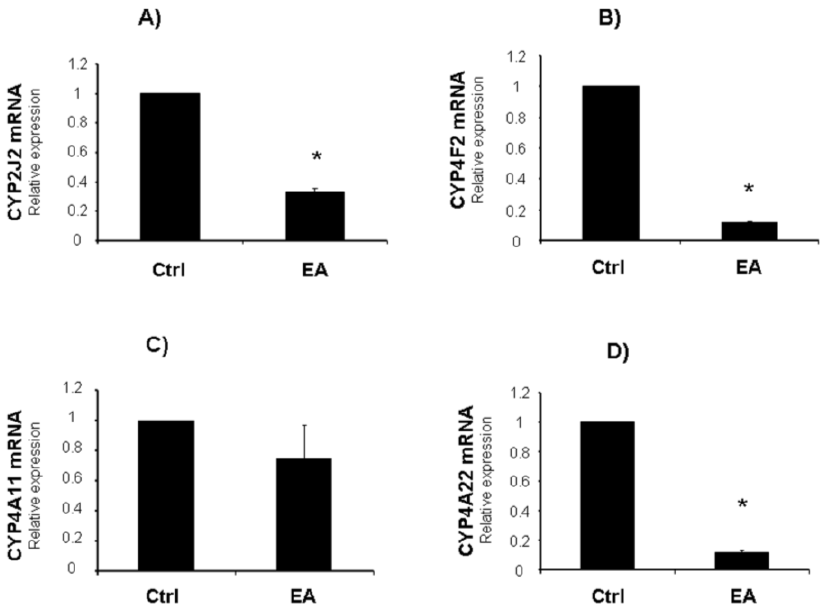
Figure 3. Effect of EA (50  M) on CYP2J2, CYP4F2, CYP4A11 and CYP4A22 mRNA levels in cultured LnCap cells ( A–D ). Results represent the mean ± SD of 4 experiments performed in triplicate. Significance of 50  M EA versus control; * p <